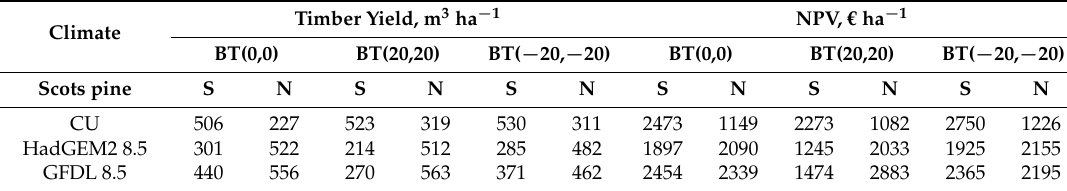
Table A3. Timber yield (m 3 ha − 1 ) and its NPV ( € ha − 1 ) over a 90-year simulation period in Scots pine, Norway spruce and birch stands on medium fertile sites in southern and northern Finland under the current climate (CU) and different climate change projections and management scenarios. S = south, N =